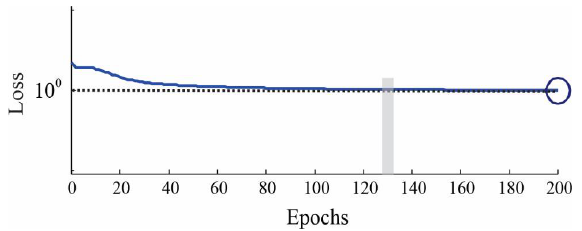
Machines 2023 , 11 , x FOR PEER REVIEW Figure 9. Obtained loss for autoencoders training. Figure 9. Obtained loss for autoencoders training.